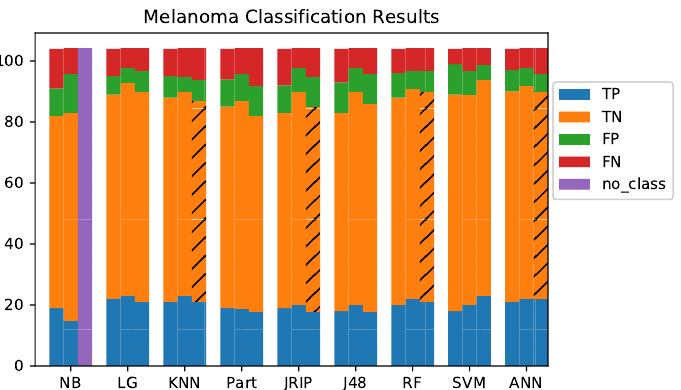
Figure A6. Graph corresponding to the Melanoma dataset. In blue are true positives, in orange are true negatives, in green are false positives, in red are false negatives, and in purple are unclassified instances.